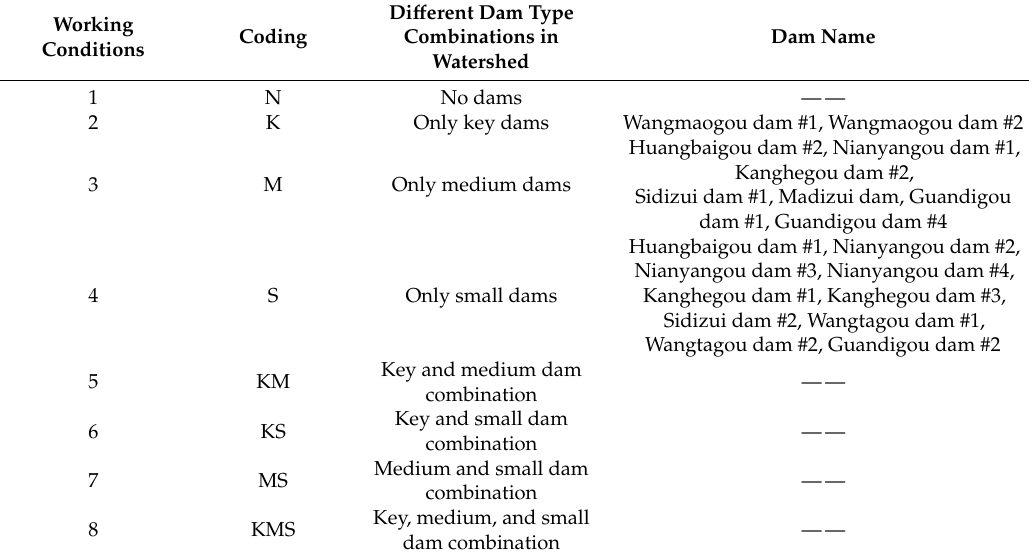
Table 2. Working condition design of di ff erent dam type